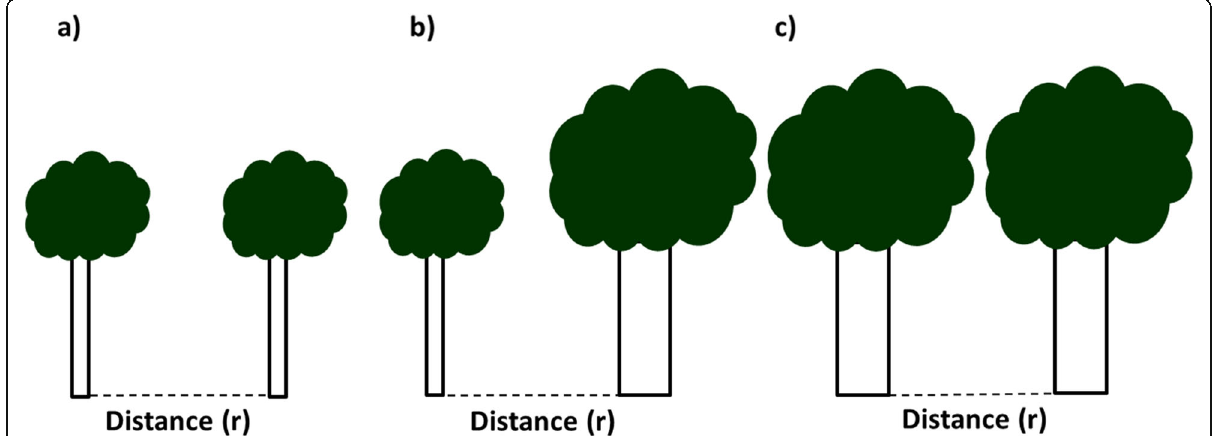
Fig. 3 Illustrations of the correlation between sizes (here DBH) of two neighbouring trees distant by r . In the case of two-sided scramble competition ( a ), the inter-tree competition is equal and the two neighbouring tree sizes are reduced, there is mutual inhibition. In the case of one-sided contest competition ( b ), one of the two trees is dominant and the other is suppressed due to asymmetric competitive abilities. In the absence of negative association, the neighbouring trees benefit from being close to each other and exercise facilitation ( c ) promoting mutual stimulation of their